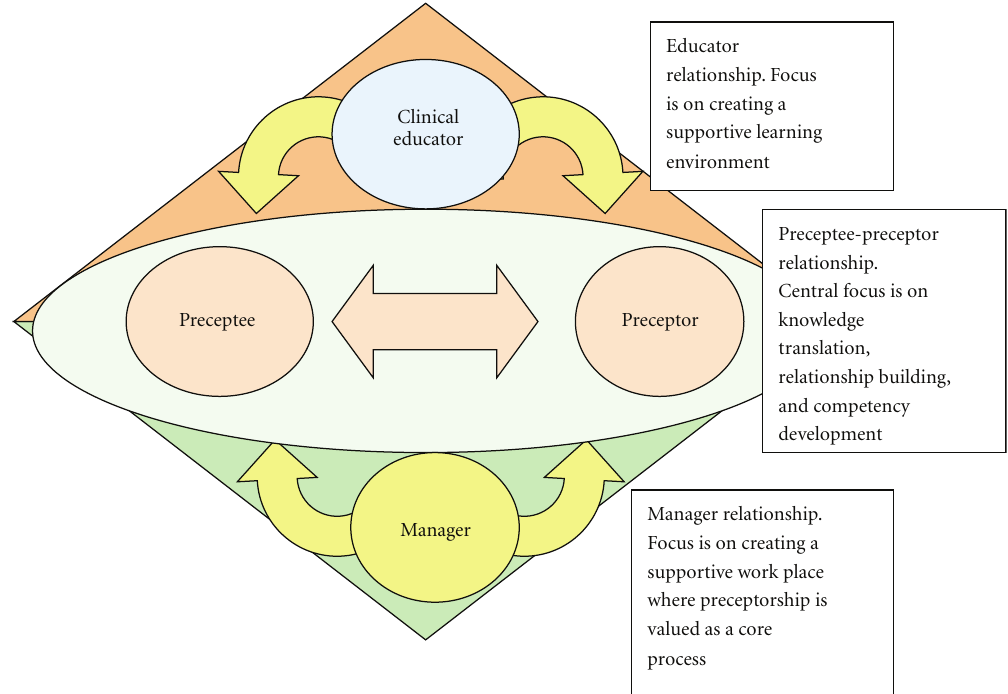
Figure 3: Schematic of